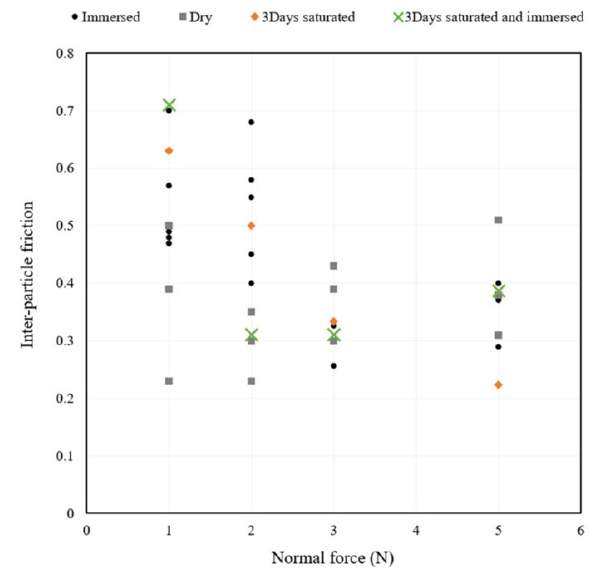
Figure 5 : Interparticle friction versus normal force for DNA-1A lunar regolith simulant at different humidity conditions (after Marzulli et al. 2021).